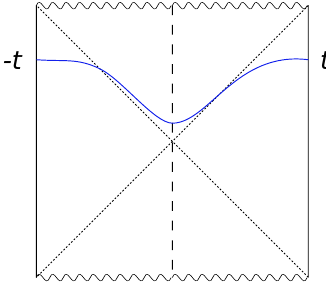
Figure 5: Wilson line stretching along a boundary-to-boundary